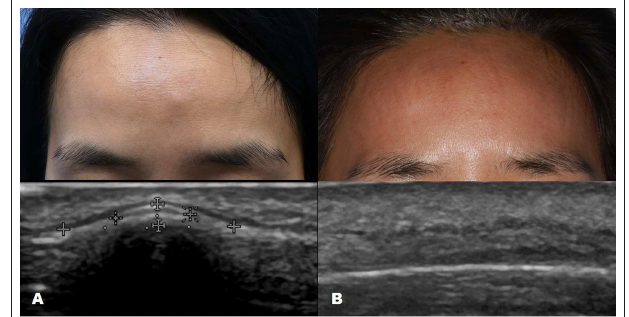
FIGURE 1 | Ultrasound images of forehead osteoma. (A) Before excision. (B) After excision performed through a remote incision above the hairline.